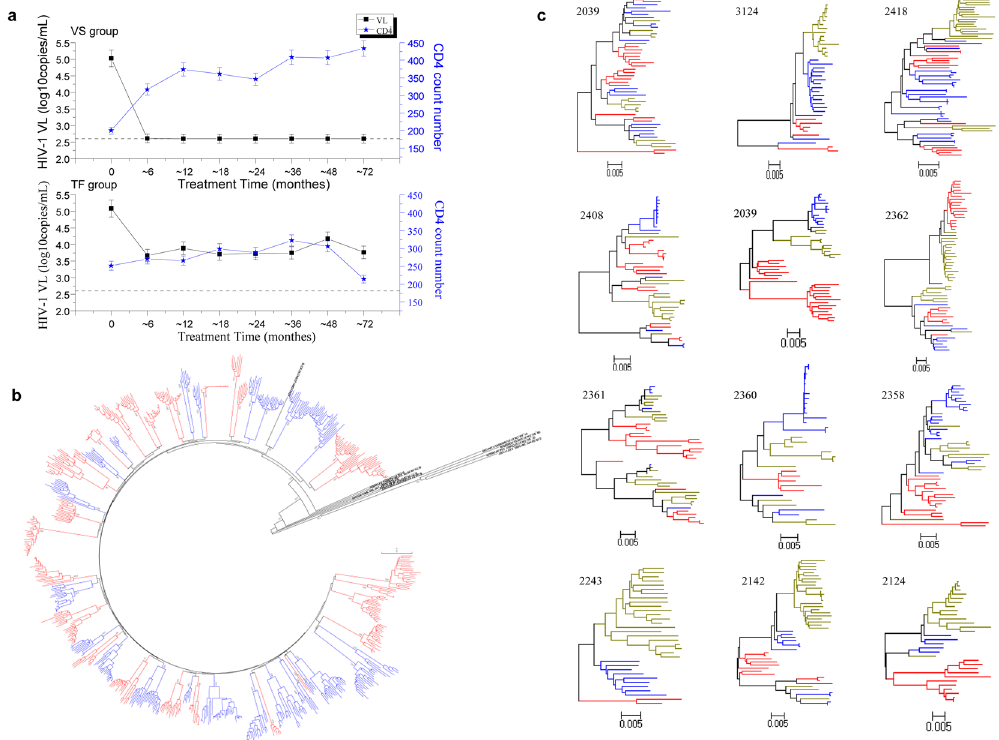
Figure 1. ( a ) Longitudinal changes in viral load (square) and HIV-1 CD4 + T cell count (pentacle) for VS (upper panel) and treatment failure TF (upper panel) during ART. HIV-1 vial load level of all VS was undetectable during ART, while the viral load levels of most TF fluctuated widely during ART, albeit lower than baseline viral load. Data are presented in mean ± standard deviation (SD) from three replicates. ( b ) Phylogenetic trees of 638 gp160 sequences at baseline between VS and TF groups. Each color represents one group (red: VS; blue: TF). Bootstrap values > 85% are shown. No sequences showed evidence of cross-contamination between study subjects or contamination with laboratory strains. As expected, all sequences for each patient were clustered together. ( c ) Phylogenetic analysis of 552 gp160 amplicons, including 169 sequences from baseline, derived from 12 TF patients (red: baseline; blue: when viral load reached a level of > 400 copies/ml; yellow: the maximum value of viral